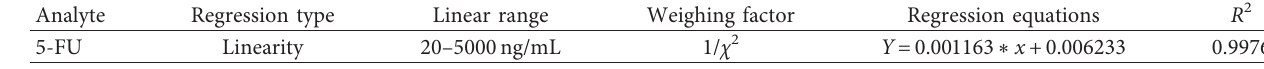
Table 2: The regression parameters of calibration curves of